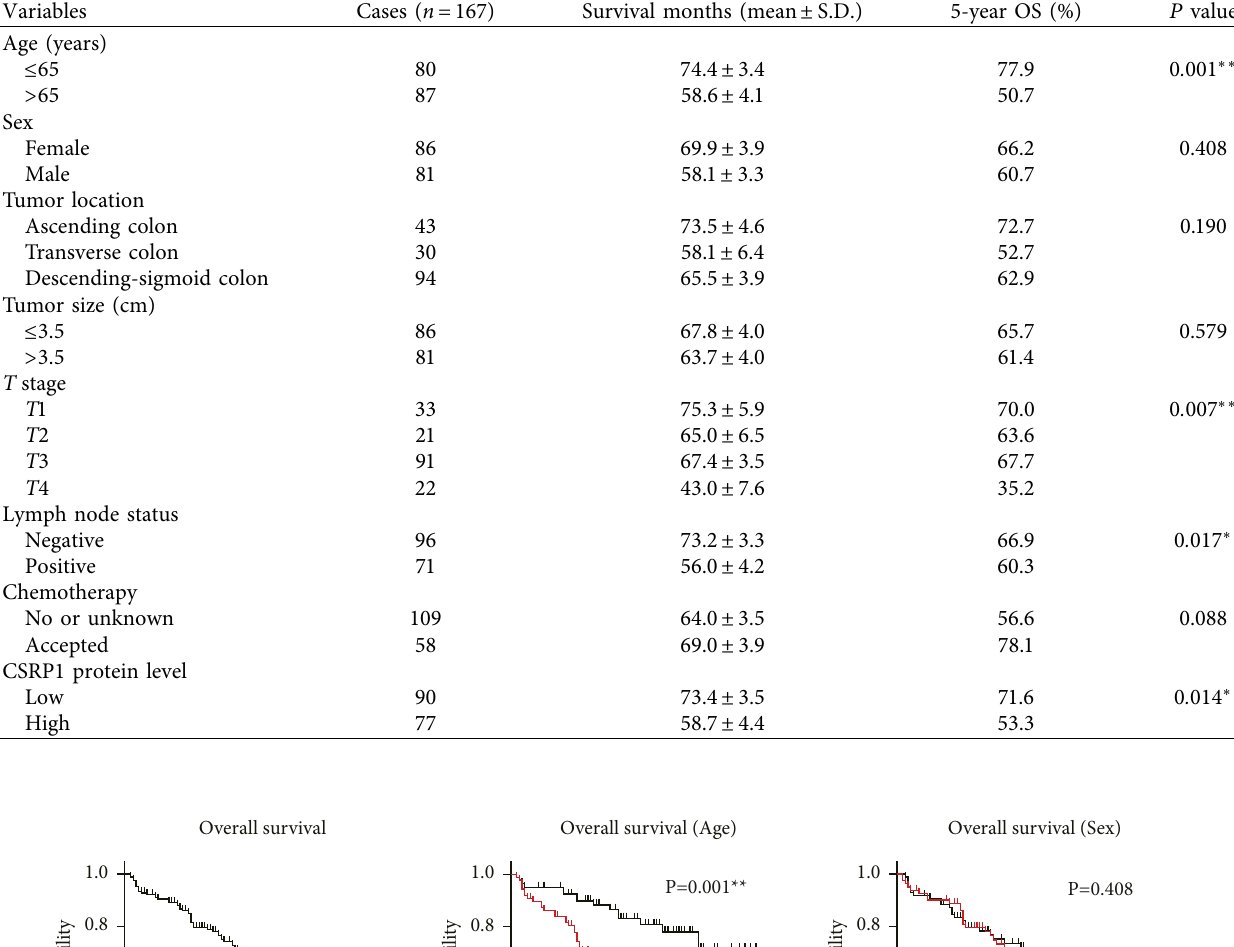
Table 2: Kaplan-Meier overall survival analyses of enrolled COAD